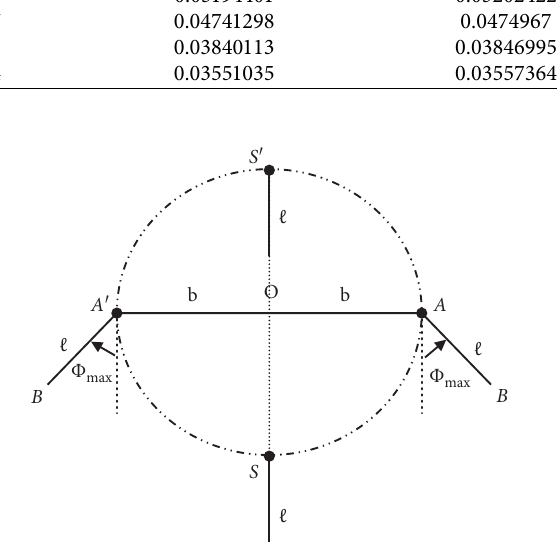
Figure 5: Description of the pendulum motion for case (ii) in Section 4.1.